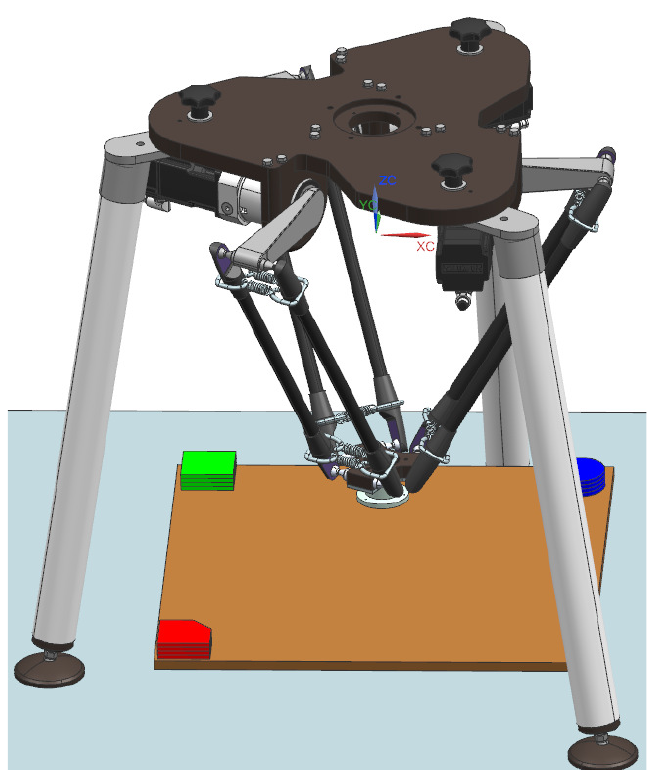
Figure 9. Digital twin of the delta robot manipulator designed in NX MCD